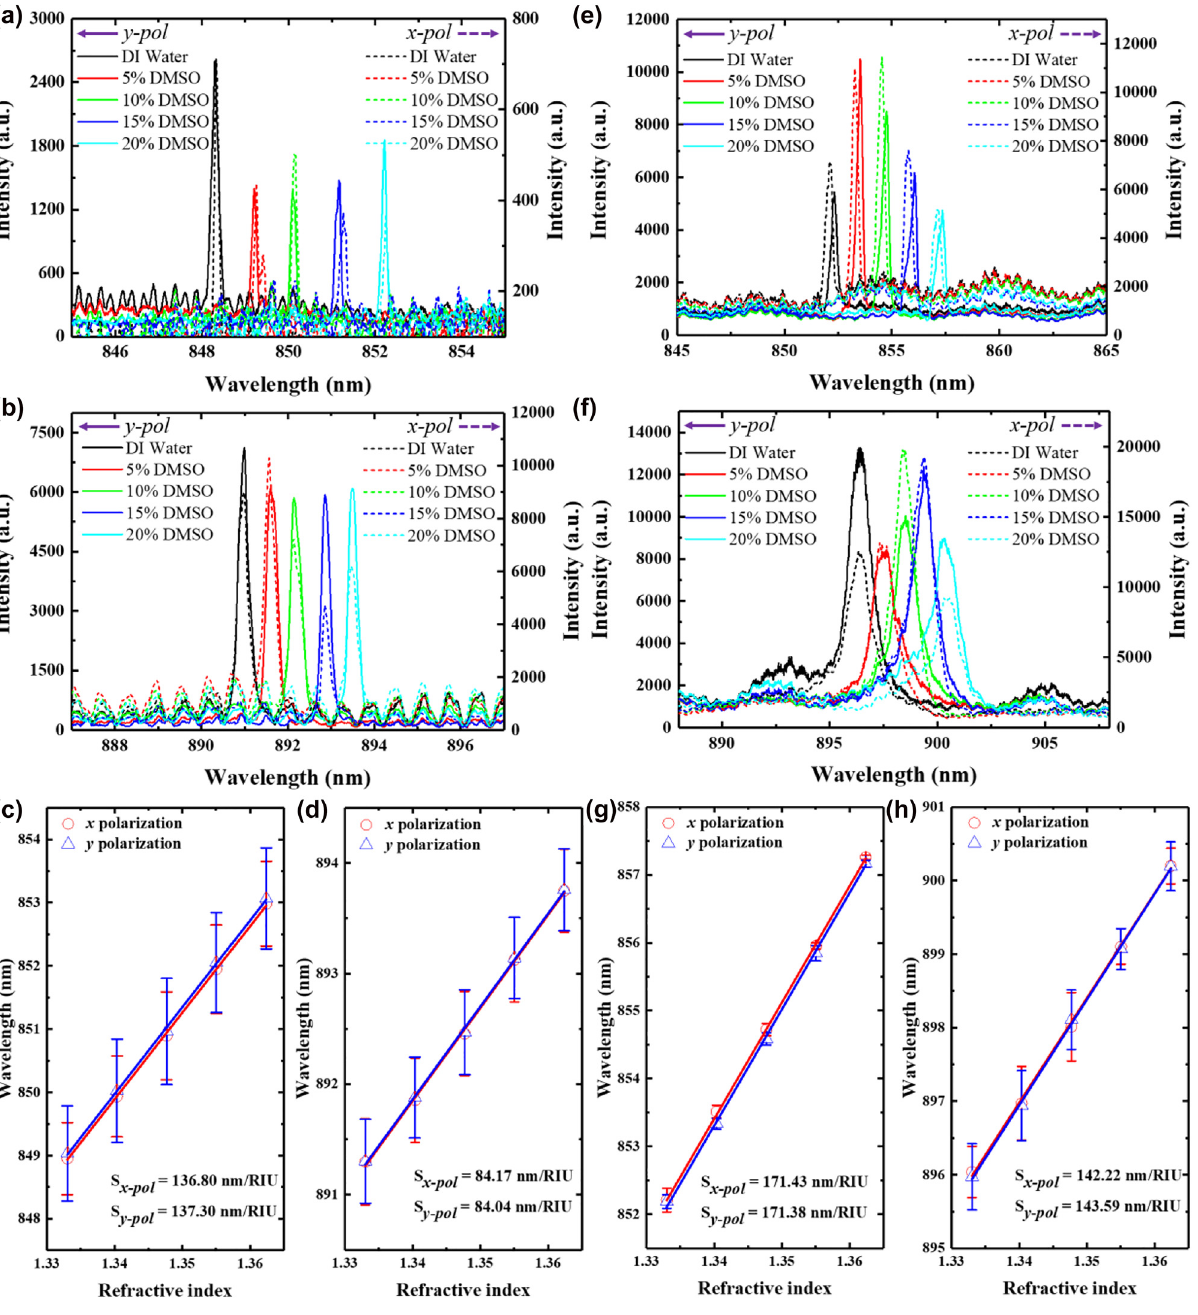
Figure 7: Reflectance spectra of TM (1,1) and TE (1,1) mode for (a, b) shallow ATM and (e, f) thick ATM immersed in DMSO–water mixture with different refractive indices. Measured resonance peaks of TM (1,1) and TE (1,1) mode position as a function of the refractive index of the solutions for (c, d) shallow ATM and (g, h) thick ATM